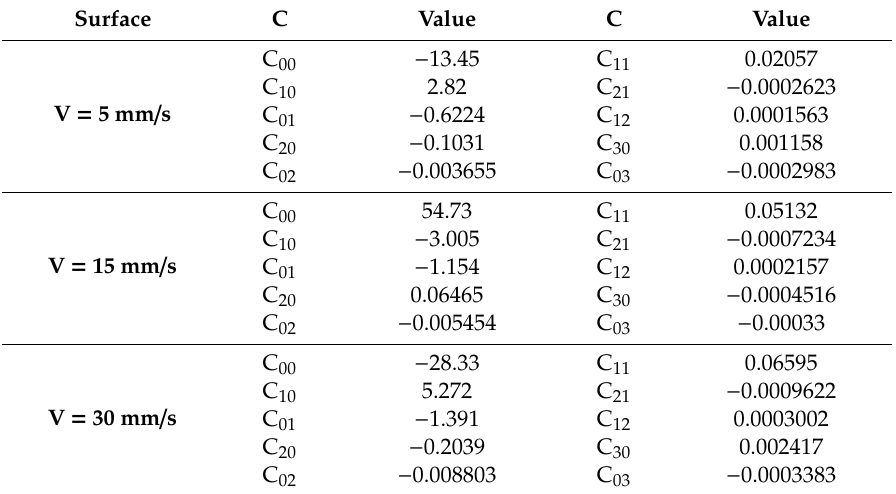
Table 5. Determined coe ffi cients of proposed equation.